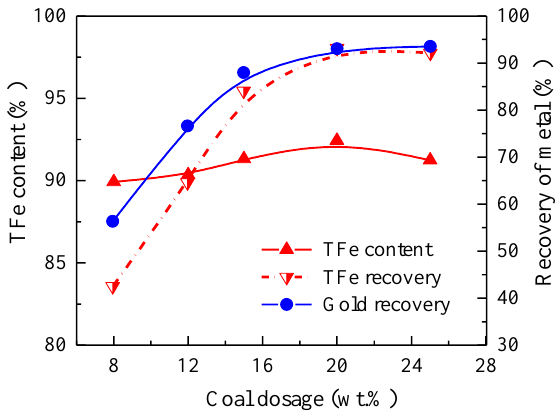
Figure 4. Effect of coal dosage on the recovery of iron and gold from cyanide tailings. (Reduction conditions: reduction temperature of 1200 °C, reduction time of 90 min, CaO dosage of 15 wt.%).